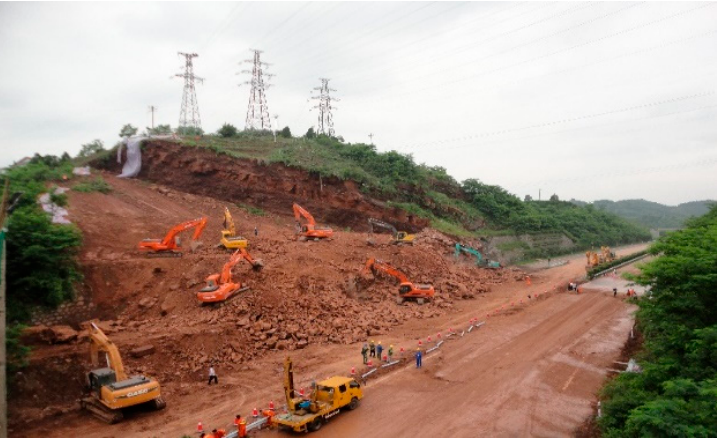
Figure 3. Landslide. Figure 3.